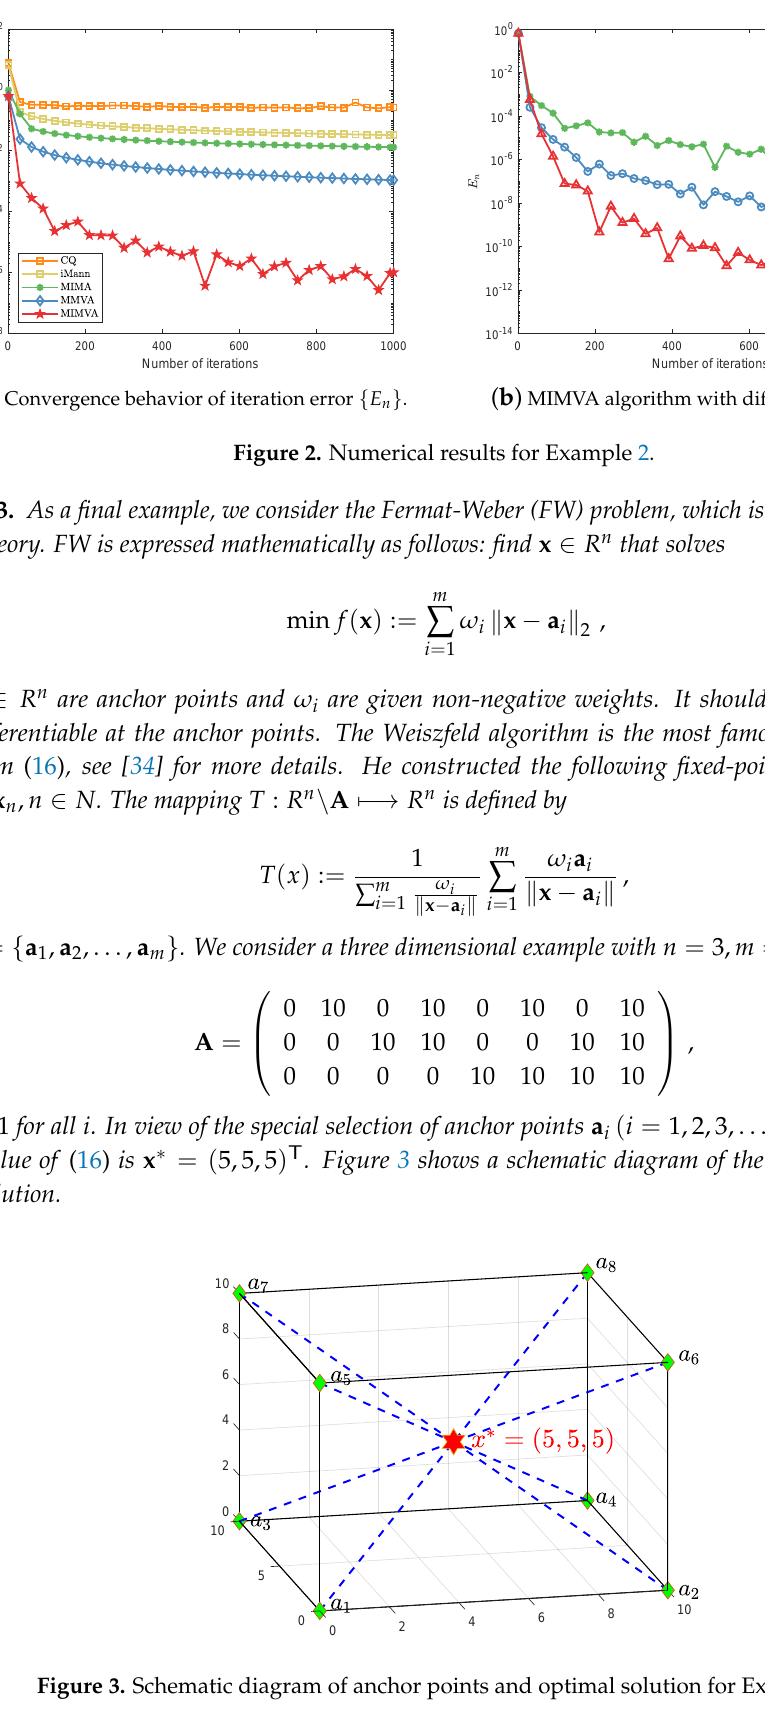
Figure 3. Schematic diagram of anchor points and optimal solution for Example